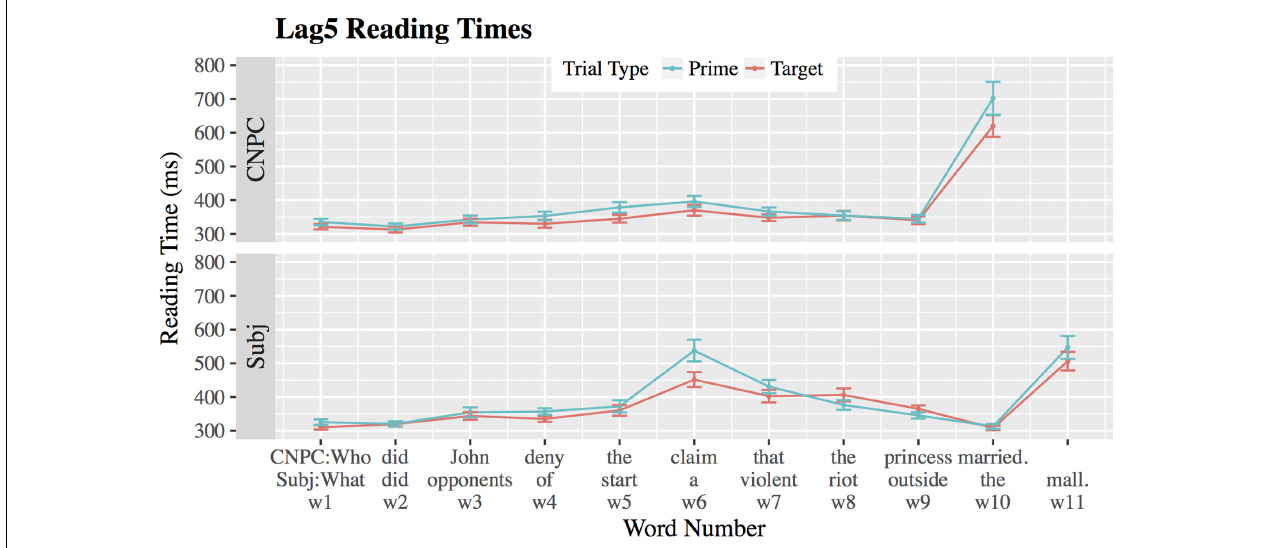
FIGURE 5 | Mean reading times (ms) for CNPC and Subject islands in Lag5. Error bars represent ± 1 standard error. TABLE 4 | Lag5 mean reading times for words in the region of interest. Lag5: Reading times